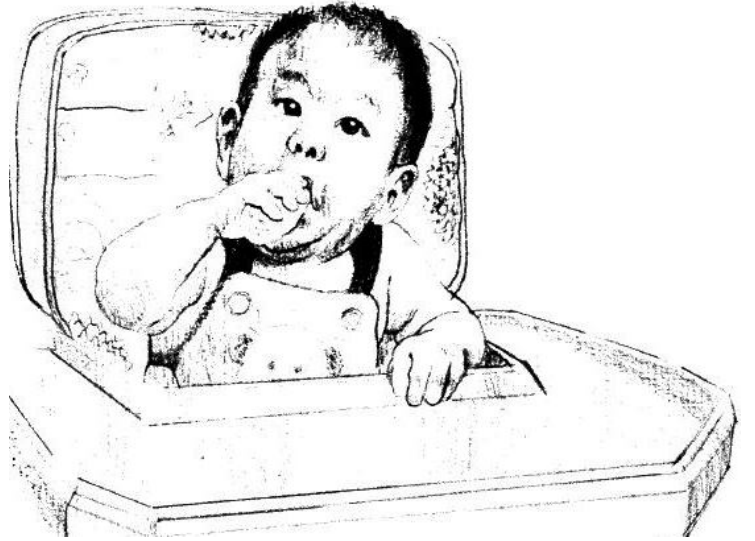
Figure 13. Baby Awaits a Meal in Highchair.